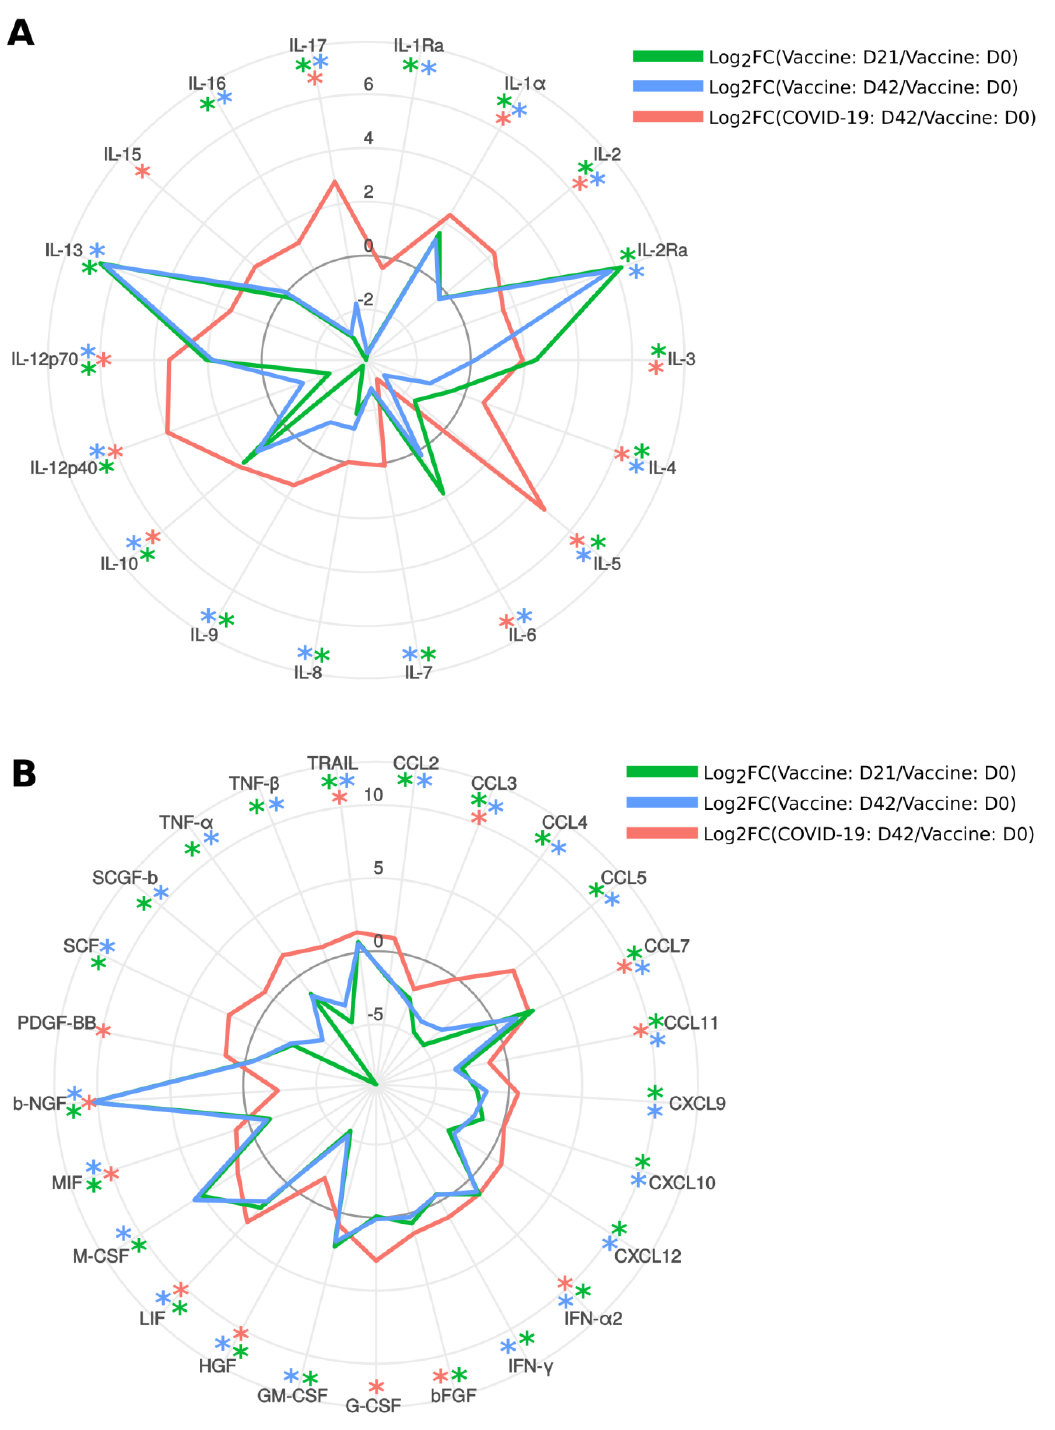
Figure 8. Analysis of cytokines in SputnikV vaccinated and convalescent COVID-19 sera. A and B Serum samples before (D0), after vaccination on D21 and D42 (21 and 42 days after the first dose of vaccine, respectively) as well as 42.0 ± 11.1 days (median ± SEM) after COVID-19 convalescence were used to analyze 48 cytokines (Bio-Plex Pro Human Cytokine 48-plex Screening Panel (12007283, BioRad, Hercules, USA)). Each sample was tested in triplicate. Data were analyzed with MasterPlex CT control software and MasterPlex QT analysis software (MiraiBio, San Bruno, CA, USA). Data are presented as a Log2 difference between a vaccinated or convalescent sample and controls. Cytokines IL-1 β , IL-18, CCL27, CXCL1 and VEGF did not differ significantly and were not included in the figure * —Significant difference between D21 and D0; * —significant difference between D42 and D0; * —significant difference between COVID-19 convalescent and